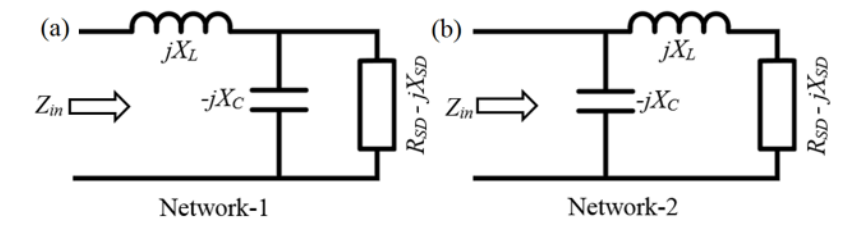
Figure 3. ( a ) Matching network-1; ( b ) matching network-2.